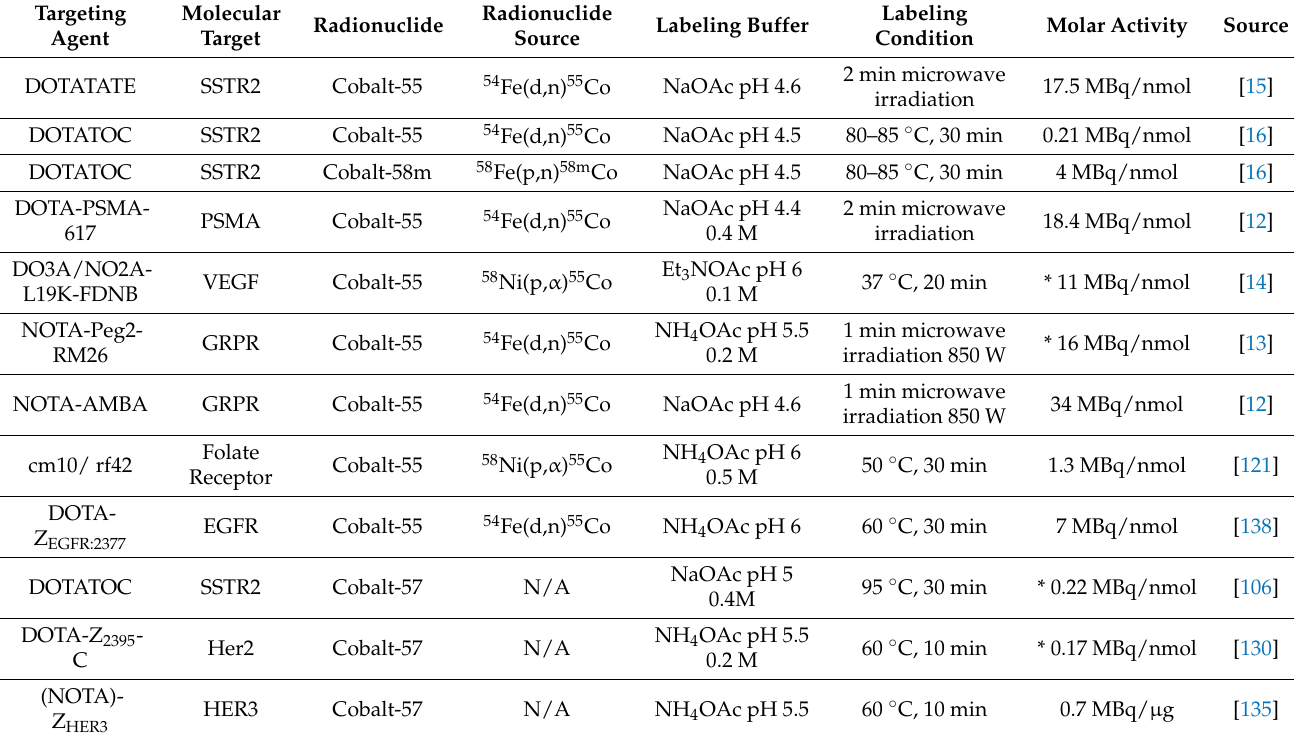
Table 3. Summary of molar activities and reaction conditions obtained for 55/58m Co with various targeting agents.